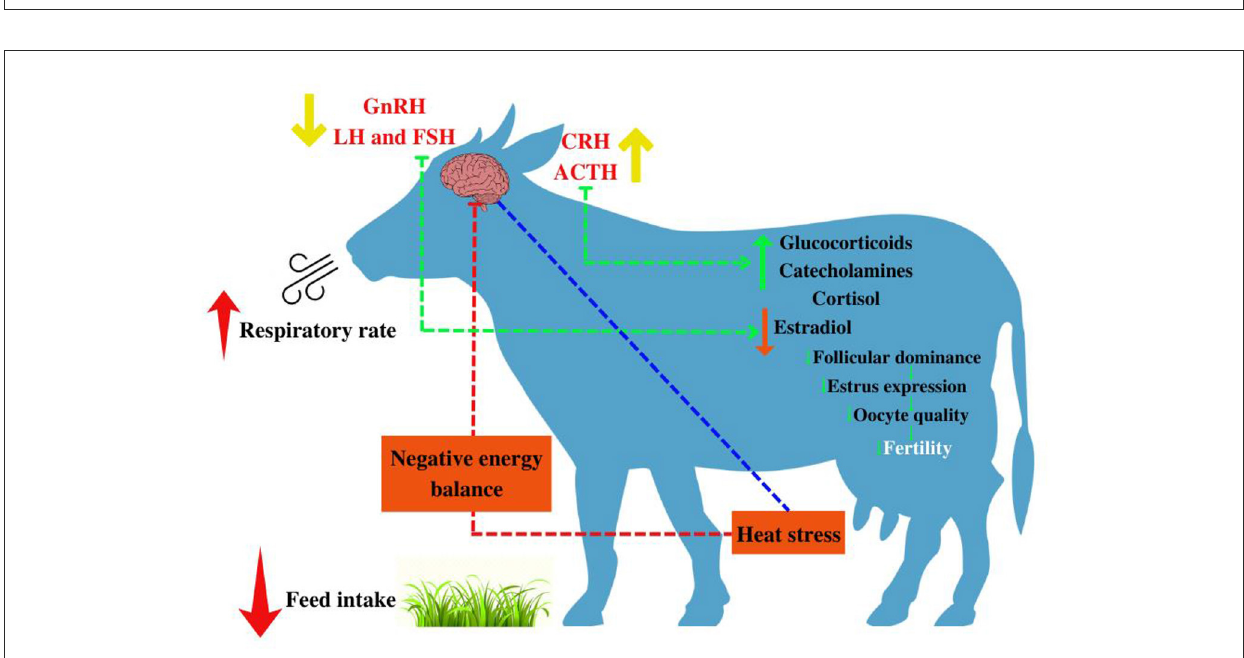
FIGURE4 Impact of heat stress on female reproductive performance. Adapted from Krishnan et al. (37). Mitigation of the heat stress impact in livestock reproduction.